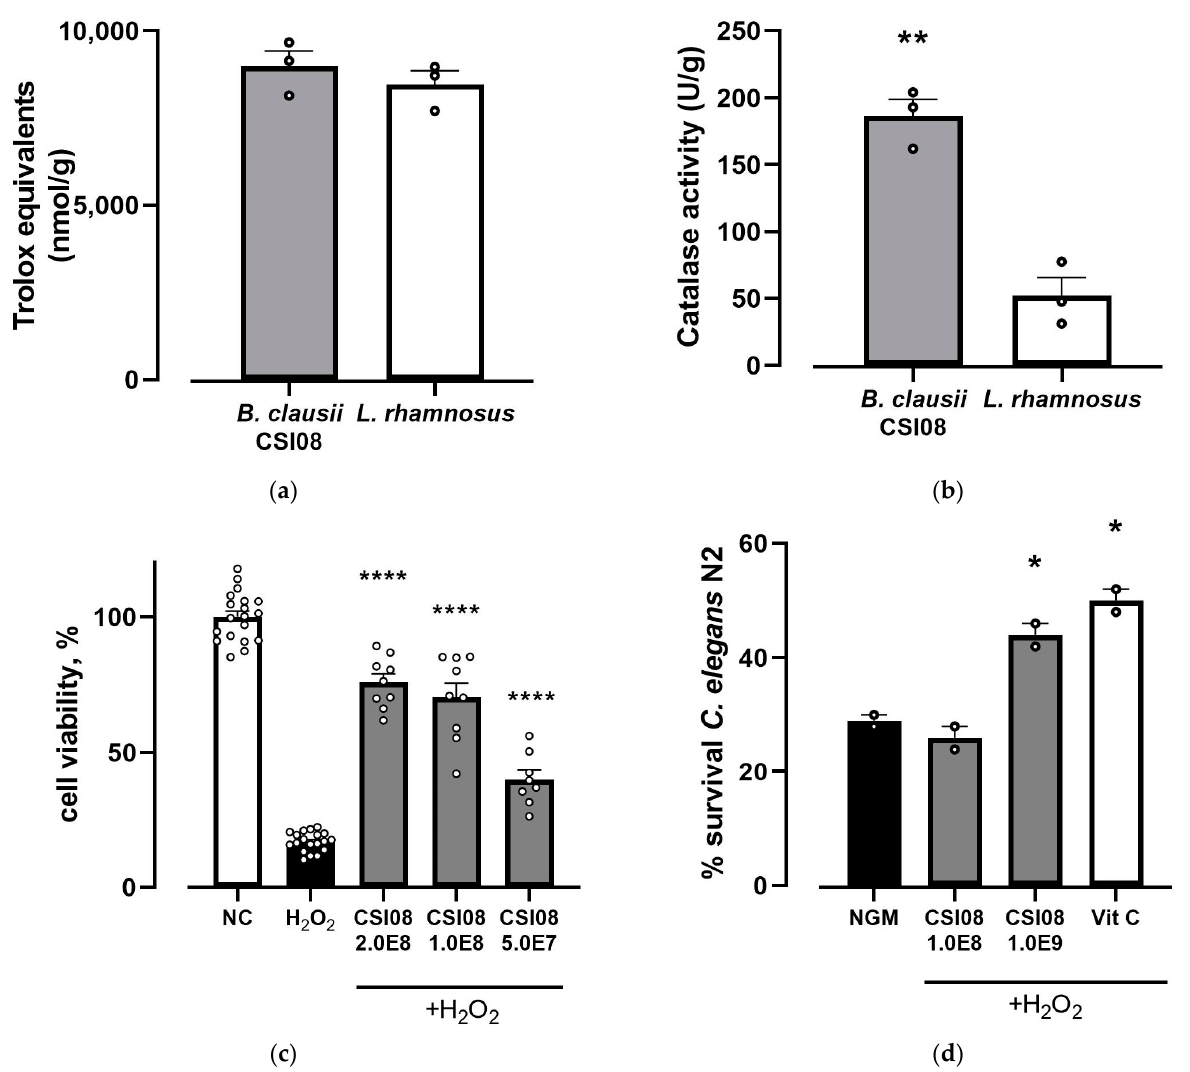
Figure 10. ( a ) Total antioxidant capacity of B. clausii CSI08 and L. rhamnosus GG cell lysates in Trolox equivalents (nmol/g). Presented values are means (n = 3) ± SEM. ( b ) B. clausii CSI08 demonstrated superior catalase activity (in U/g) as compared with L. rhamnosus GG cell lysates. Values are means (n = 3) ± SEM. ** p < 0.01. ( c ) Cytoprotective effect of B. clausii CSI08 on H 2 O 2 -exposed epithelium. Data represent percentage of XTT dye conversion 20 h after exposure to 4 mM H 2 O 2 by HT-29 cells preincubated with 2.0 × 10 8 , 1.0 × 10 8 , 5.0 × 10 7 CFU of B. clausii CSI08 compared with control group (NC). The values are the means ± SEM. **** p < 0.0001 vs. H 2 O 2 . ( d ) Survival rate of C. elegans N2 fed with 10 8 and 10 9 CFU/mL B. clausii CSI08 followed by an acute oxidative stress caused by 2 mM H 2 O 2 . NGM—control-fed nematodes; Vitamin C as a positive control. Values presented are the average of two independent experiments (n = 100/condition). * p <